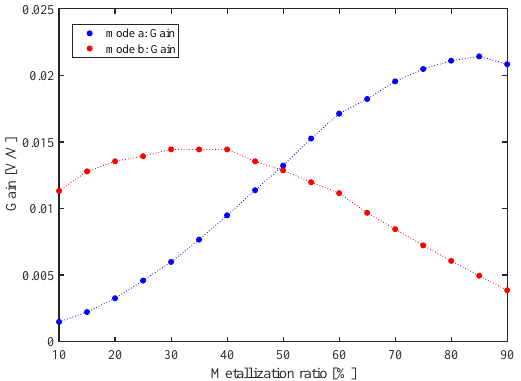
Figure 9. Transmission gain with respect to IDT metalization ratio.